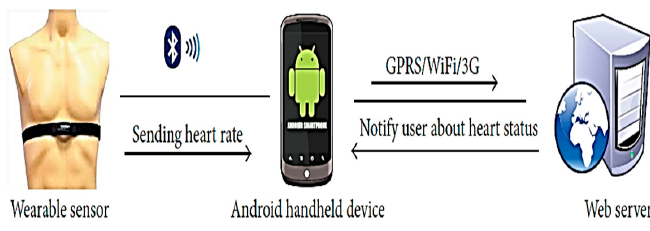
Figure 8. The system configuration of the remote patient monitoring application [16].